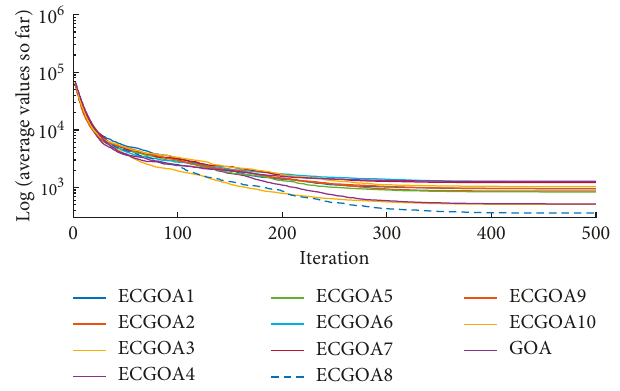
Figure 4: Convergence curve for function 1 (30-D).